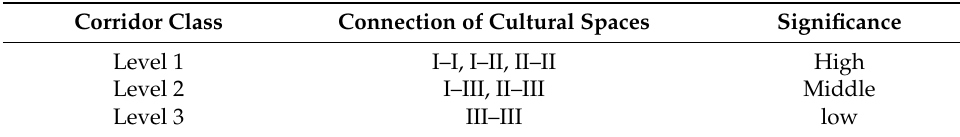
Table 3. Division of corridor classes and their